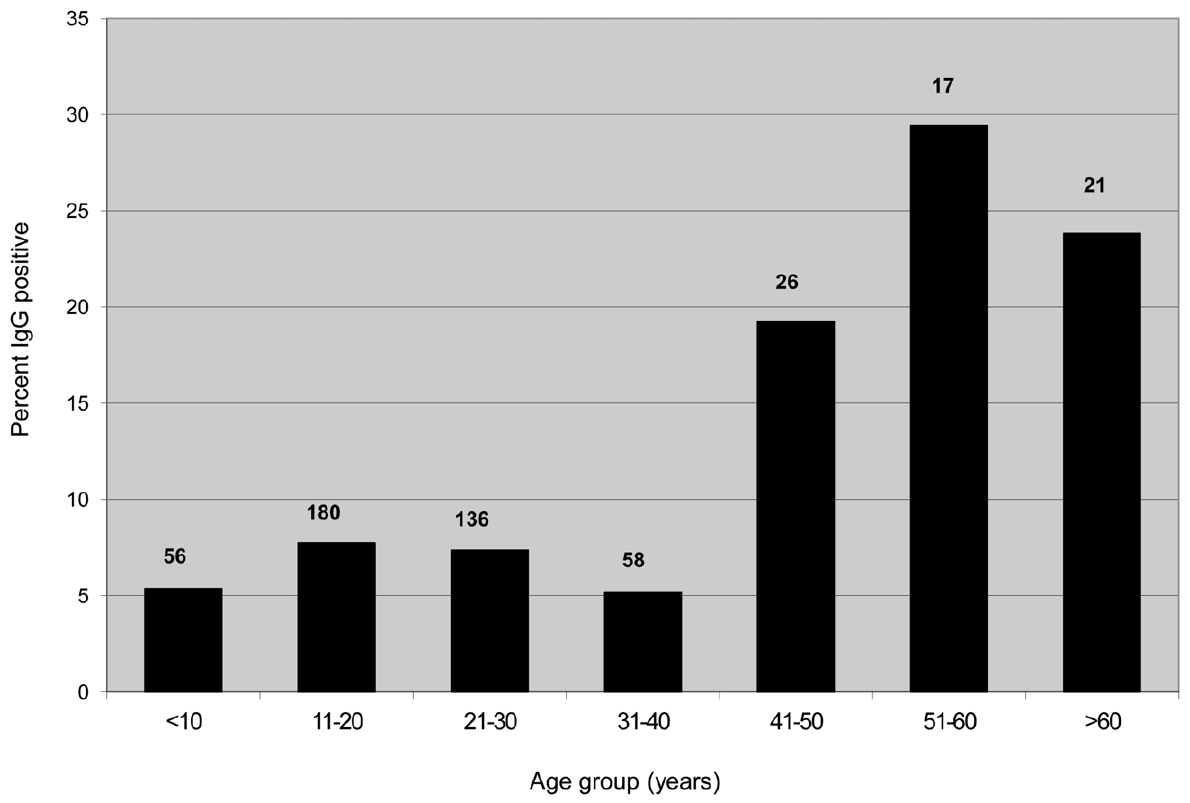
Figure 2. Hantavirus IgG antibody prevalence by age group in Mineros and Concepcion, Bolivia, 2002. Numbers on top of the bars indicate the total number of persons tested in that age group. doi:10.1371/journal.pntd.0001840.g002 PLOS Neglected Tropical Diseases |